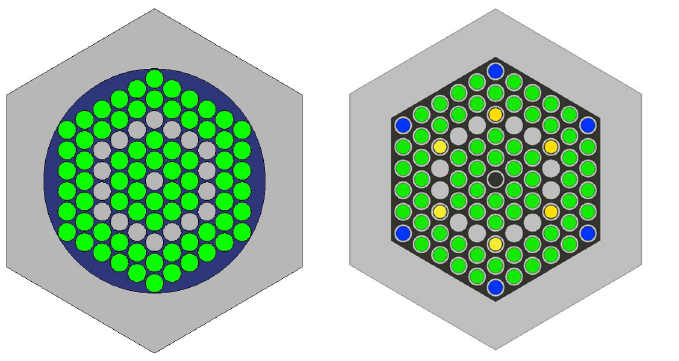
Figure 1. Original Assembly (Left) and Modified Assembly